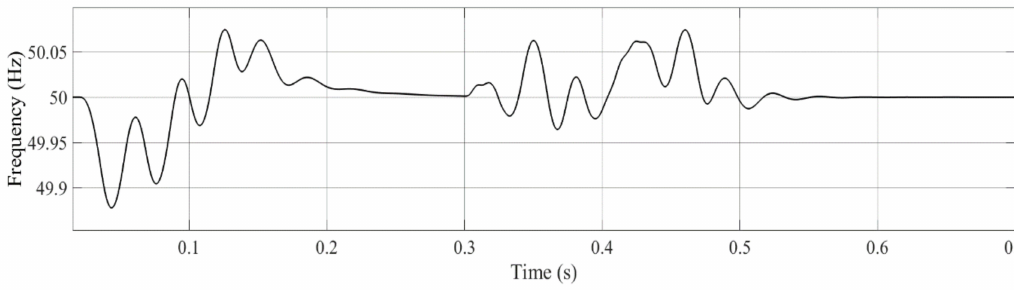
Figure 6. A self-frequency restoration at the fundamental